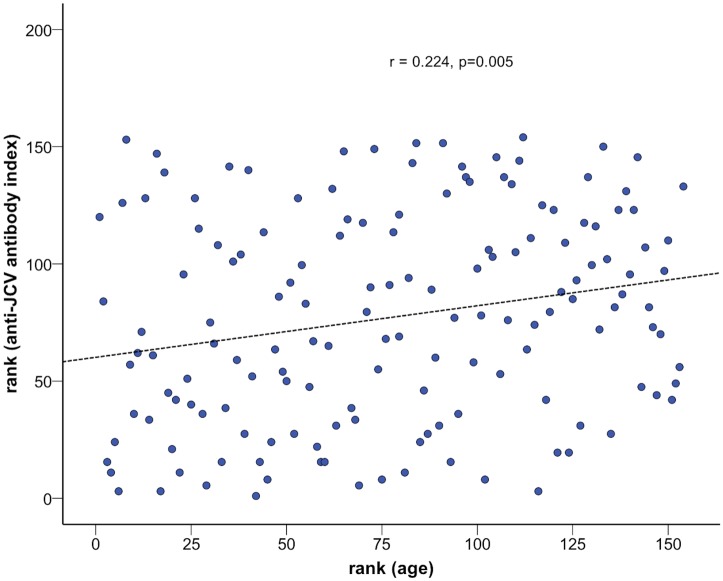
Spearman correlation between anti-JCV antibody index and patients’ age.The correlation between the rank of patient's age and the rank of anti-JVC antibody index is visualized, i.e. the Spearman correlation coefficient with its significance.